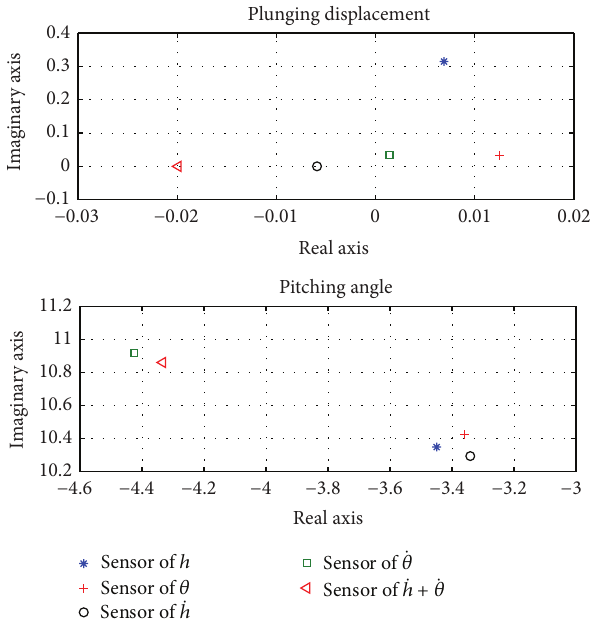
Figure 9: Closed-loop eigenvalues of the system with different sensor signals for moderate stall case.